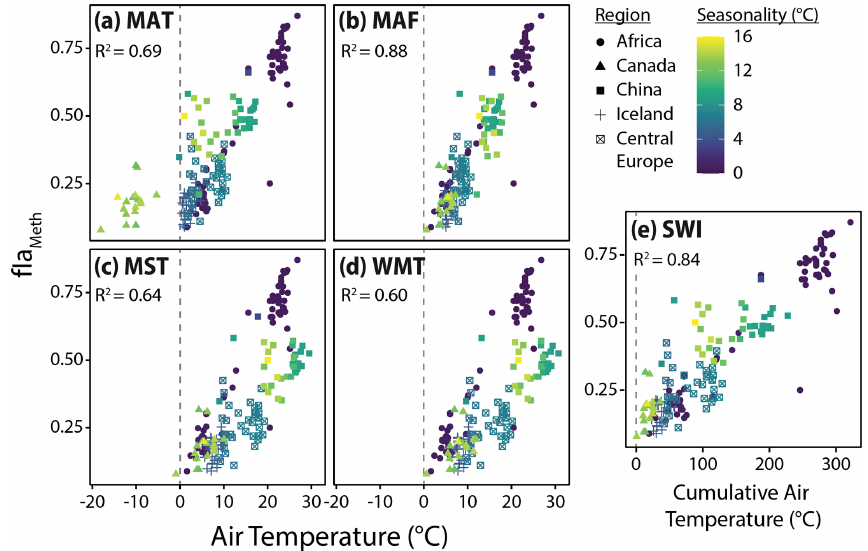
Figure 6. Relationships between fIa Meth and the five air temperature variables tested in this study, (a) mean annual temperature (MAT), (b) months above freezing (MAF), (c) mean summer temperature (MST), (d) warmest month temperature (WMT), and (e) summer warmth index (SWI). Colors indicate air temperature seasonality (standard deviation of mean monthly temperatures). Dashed lines indicate mean or cumulative temperatures of 0 ◦ C for reference. R 2 values for the relationship between fIa Meth and each temperature variable are provided in each